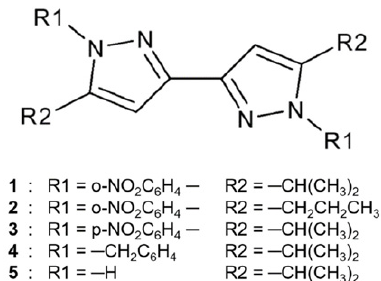
Fig. 1. Molecular structure of compounds considered in this